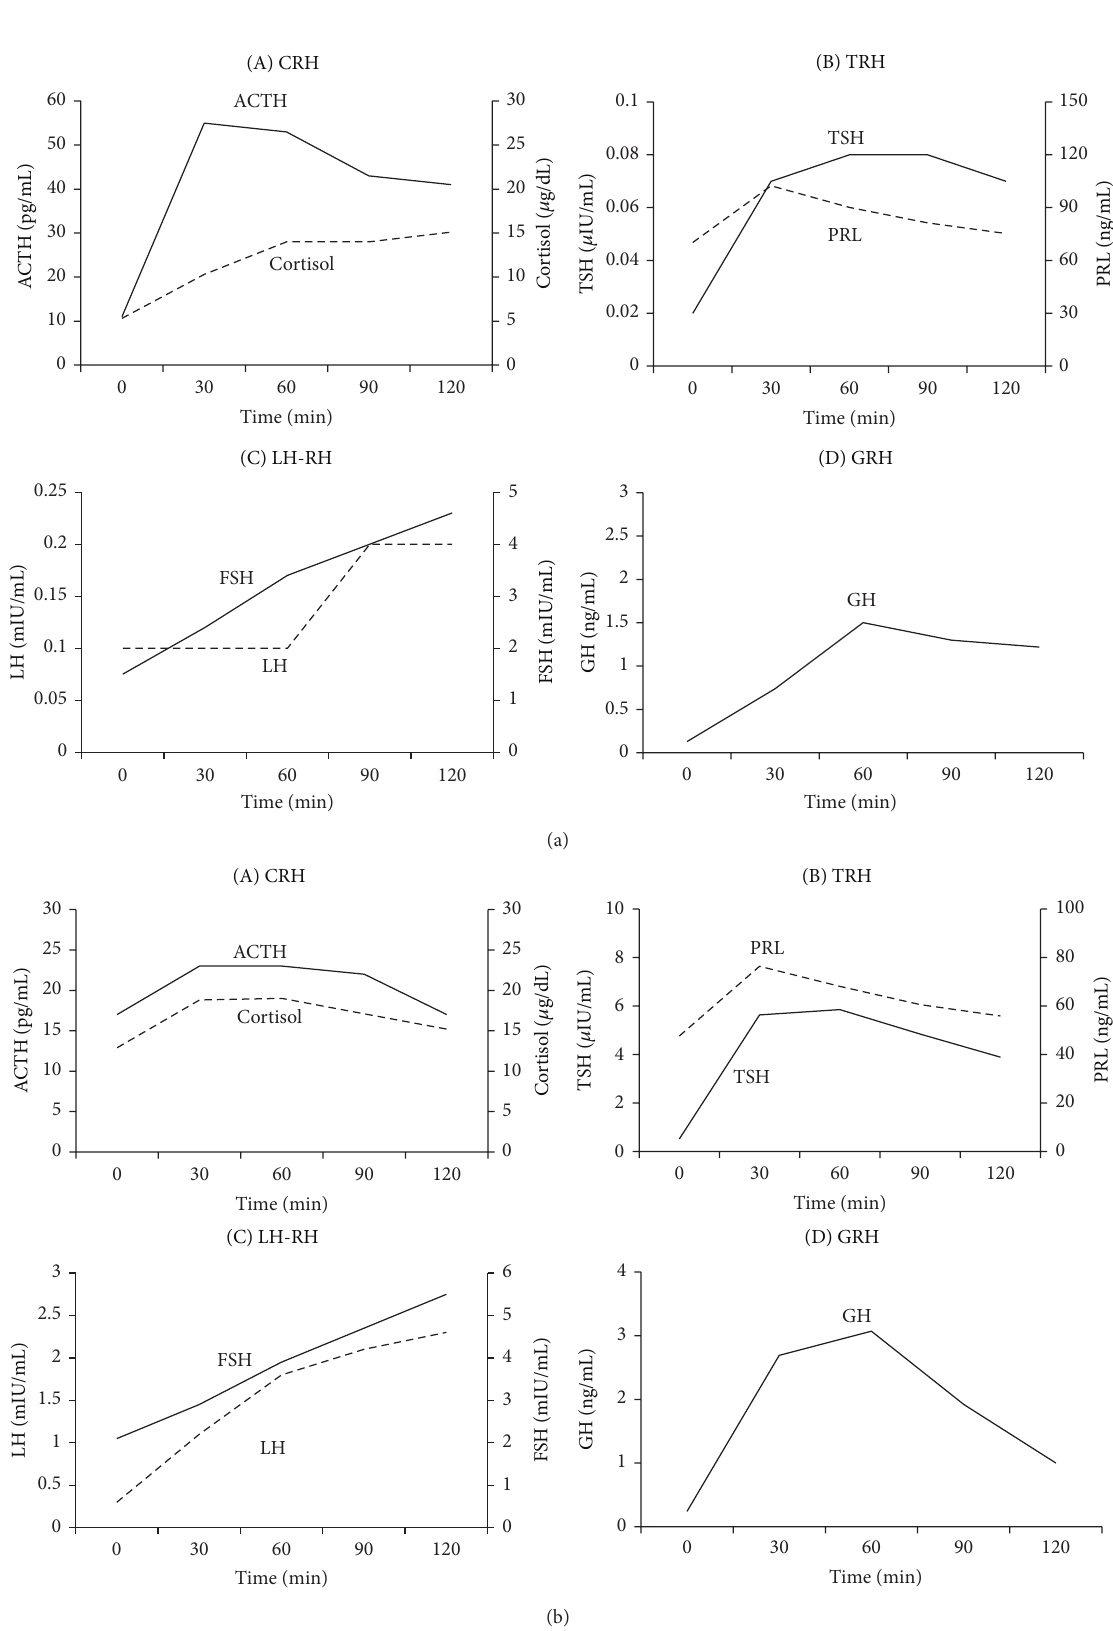
Figure 1: Dynamic endocrine tests before (a) and after (b) surgery. Stimulation with (A) CRH (100 𝜇 g), (B) TRH (500 𝜇 g), (C) LH-RH (100 𝜇 g), and (D) GRH (100 𝜇 g) is